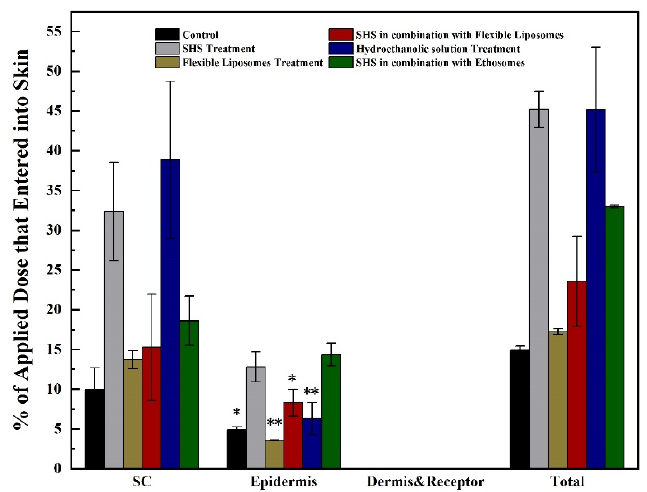
Figure 7. SHS in combination with ethosomes (SpEt) significantly increased the accumulation of CysA in viable epidermis in vitro. * represents p < 0.05, ** represents p <